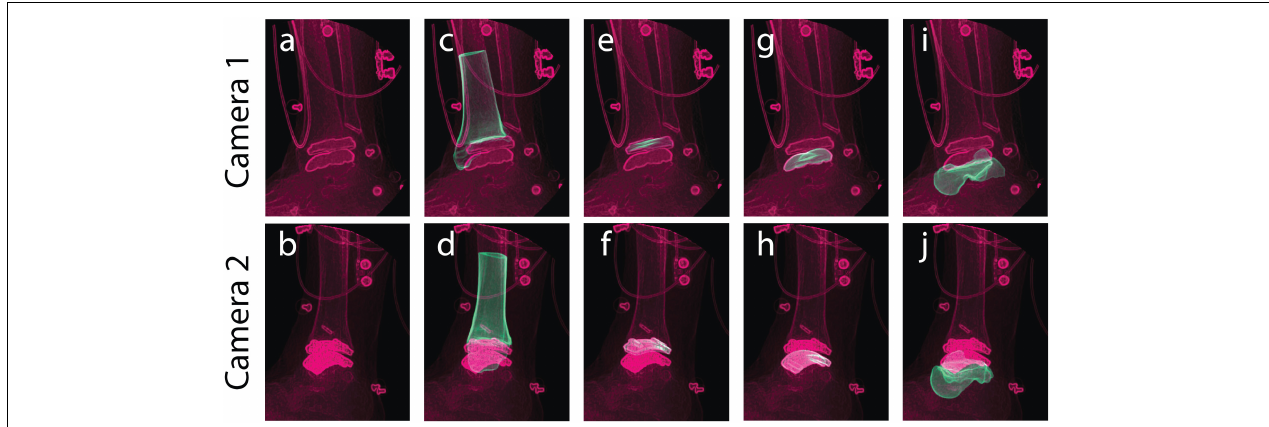
FIGURE 5 | Tracking was performed in a static standing position for bone and implant models to yield individual structure positional and rotational solutions to establish a combined hybrid model. Camera 1 and camera 2 show the two calibrated DF views for a single frame in the static trial. Multiple views of the same static frame demonstrate the raw DF images (a,b) , and individual tracking solutions for the: tibia (c,d) , tibial component (e,f) , talar component (g,h) , and talus (i,j) .